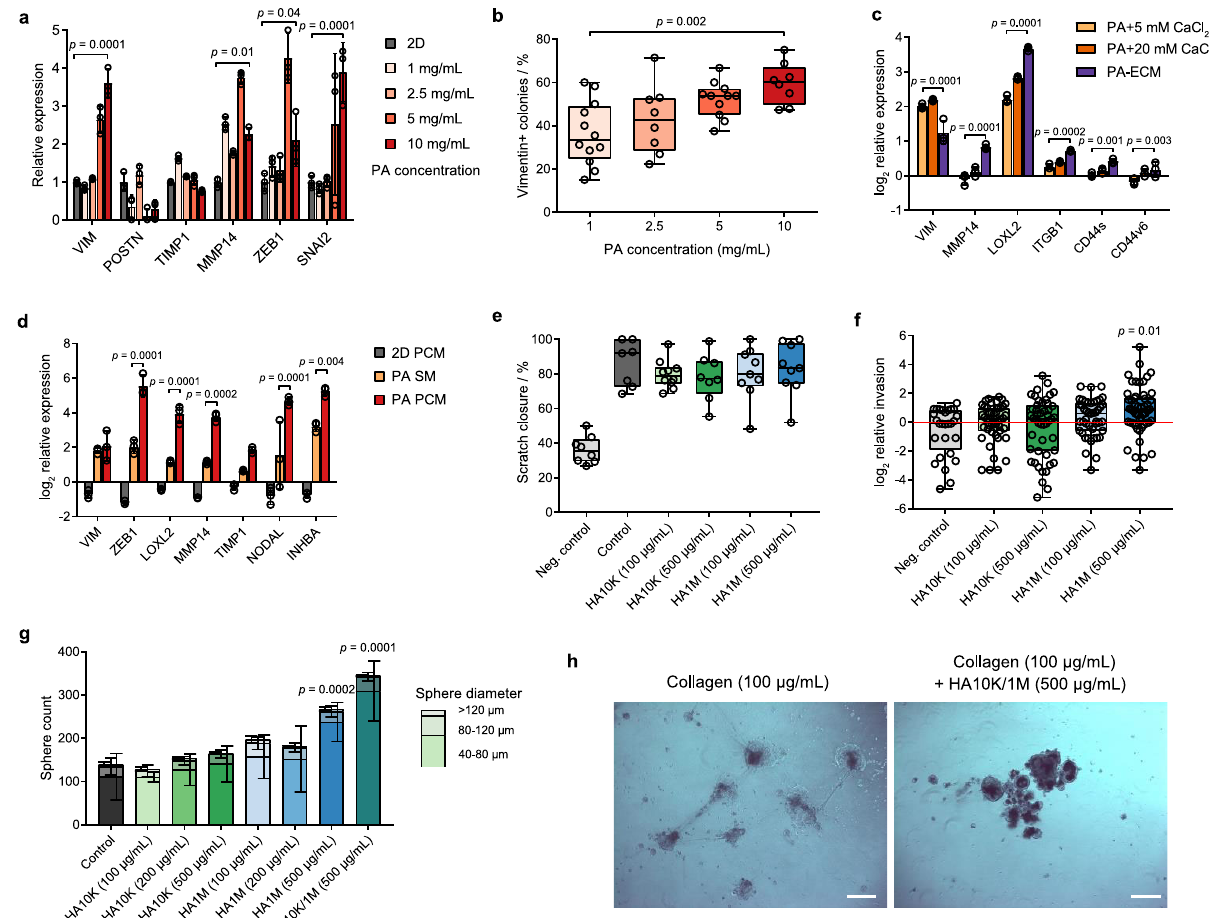
Fig. 5 Control over PDAC cell phenotypes in PA hydrogels. a Gene expression of PDAC cells (12560) as a function of PA concentration relative to 2D controls (mean ± SD; n = 3 biological replicates). p values were calculated by two-way ANOVA with Bonferroni correction. b Percentage of